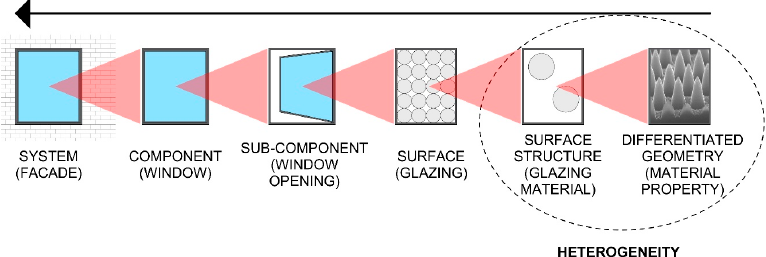
Figure 9. How buildings can achieve multifunctionality through integrating hierarchical building components with heterogeneous forms of material properties.